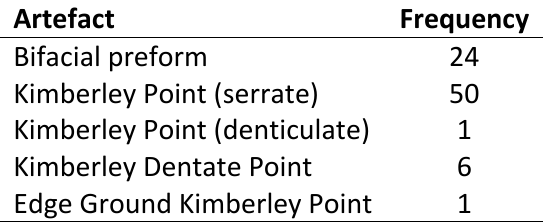
Table 3. Ethnographic collection artefact frequency.